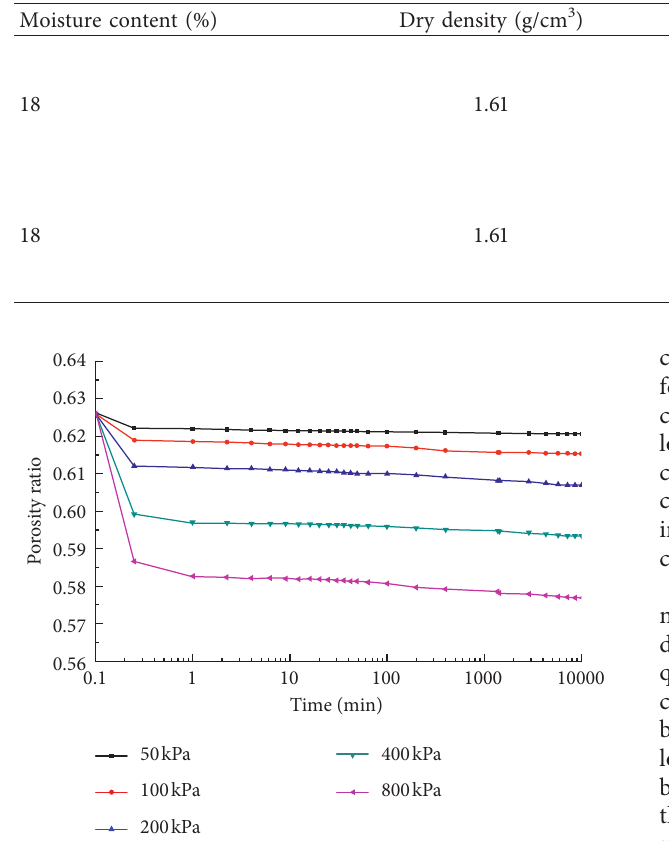
Figure 4: Consolidation test curve of expansive soil under one- time loading